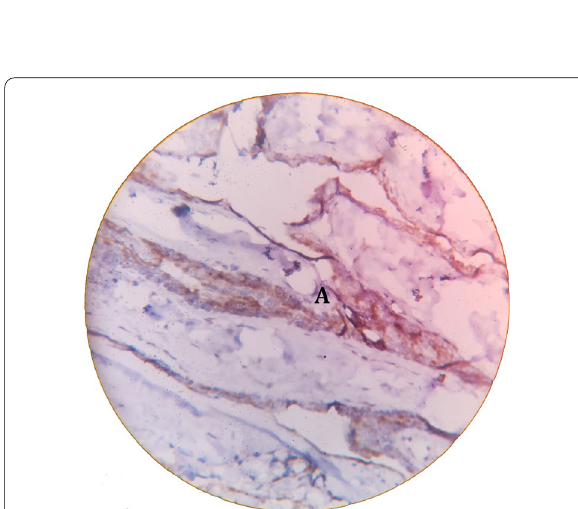
Fig. 14 IHC 20 image; showing pankeratin positivity seen in a cyst × wall lining epithelium shown as ‘A’